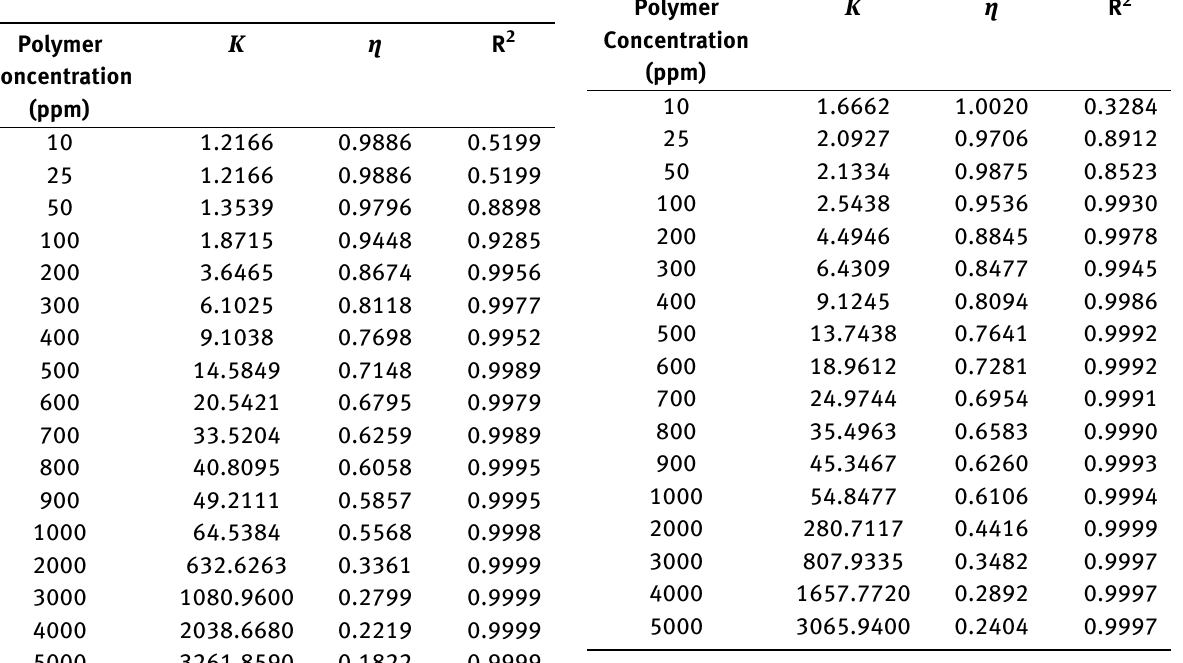
Table 3: Fit parameters to the Power Law Model for 23 ∘ C/20,000 ppm NaCl